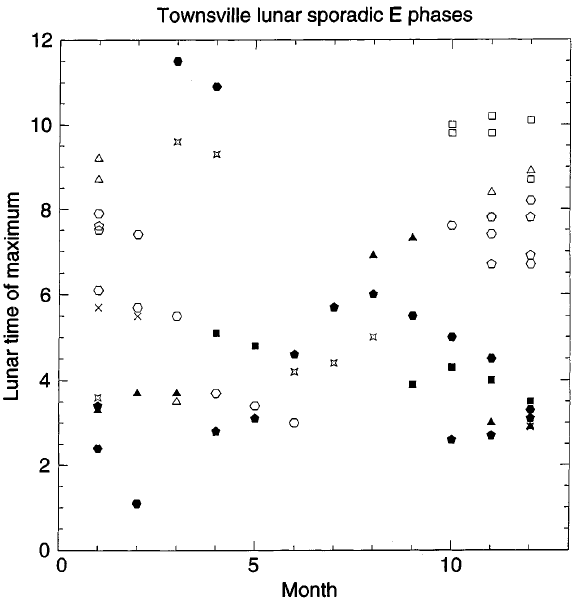
Fig. 5. A series of determinations of the phase of the lunar tide in Es at Townsville as a function of month of the year. Solid symbols represent h ¢ Es and open symbols represent f oEs or f bEs. Di(cid:128)erent symbols represent di(cid:128)erent two-year data sets. See text for